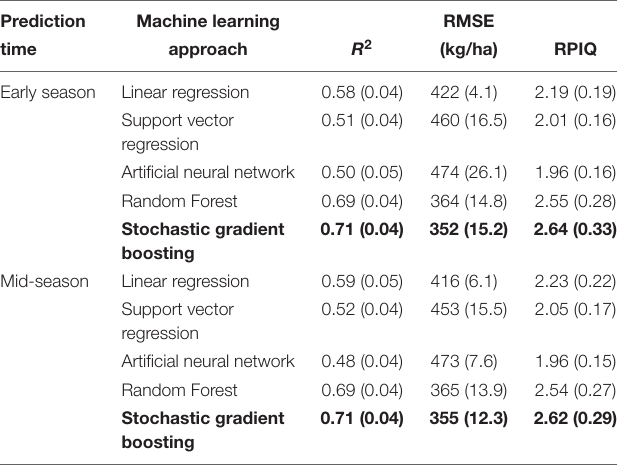
TABLE 2 | Comparison of the performance of five machine learning approaches for orchard-level almond yield prediction, when using the full set of input variables. Prediction